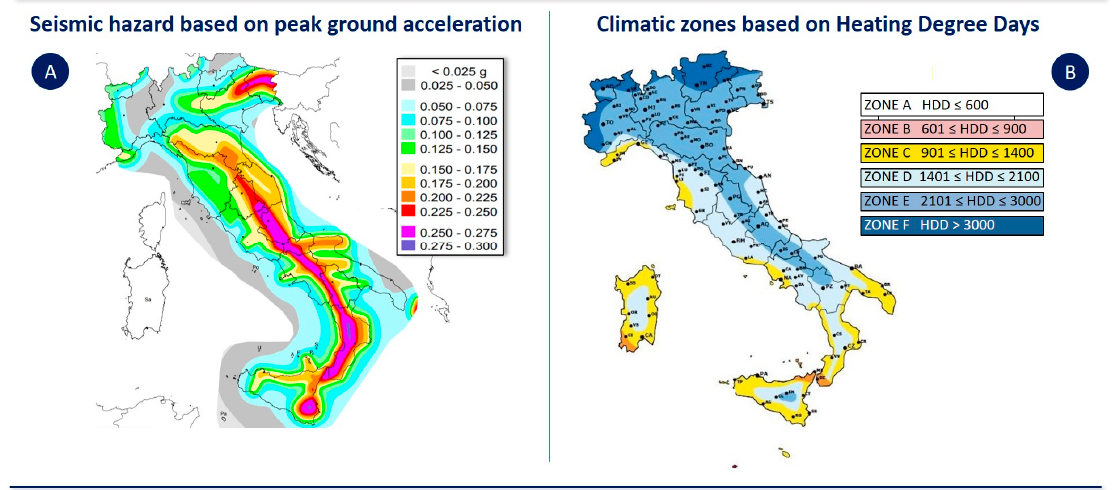
Figure 4. Italy: ( a ) Seismic hazard map; ( b ) climatic zone map.